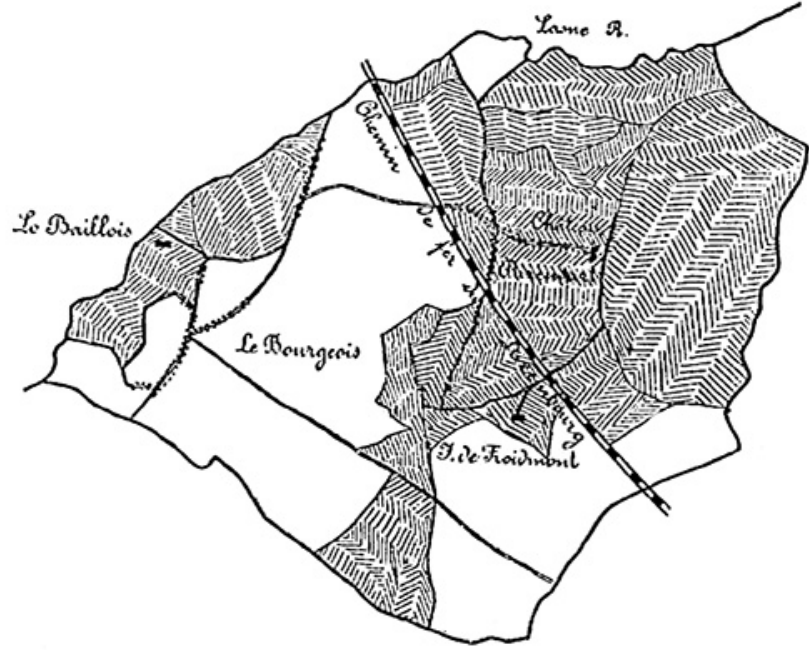
Figure 2. De Merode’s properties in Rixensart municipality (gray areas). Source: Vandervelde